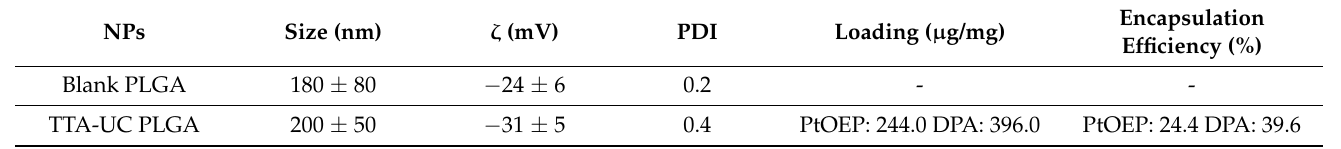
Table 1. Physicochemical properties of NPs. Data are presented as average ± SD (N =